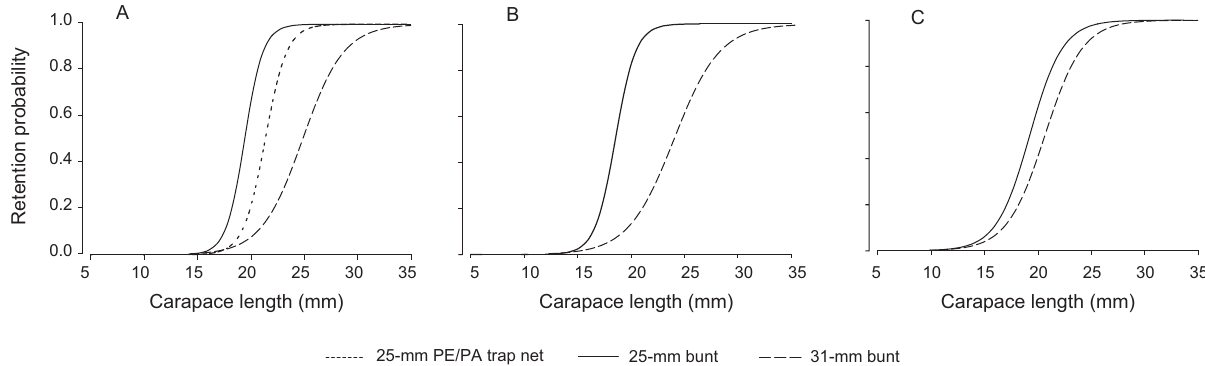
F IG . 4. – Logistic selection curves for A) eastern king, B) greasyback and C) school prawns for the various treatment trap-net configurations. T ABLE 2. – Carapace and fork lengths (mm) at 50% probability of retention (L ), selection ranges (SR) and relative fishing efficiencies ( p ) 50 for greasyback prawns, eastern king prawns, school prawns and southern herring from the various trap-net configurations. Standard errors